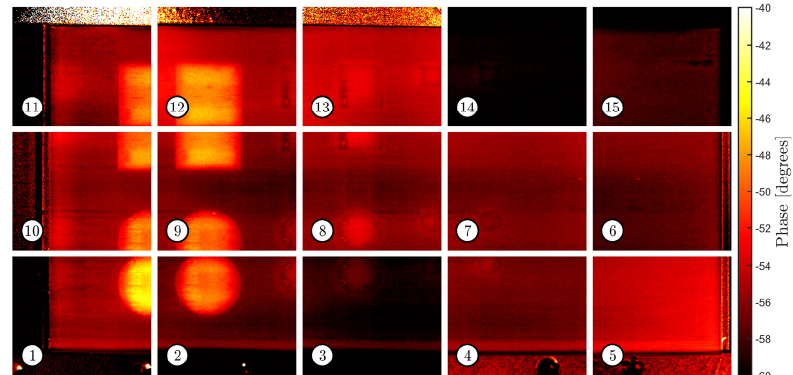
Figure 9. Set of phasegrams taken from the sample with the superposed grid.